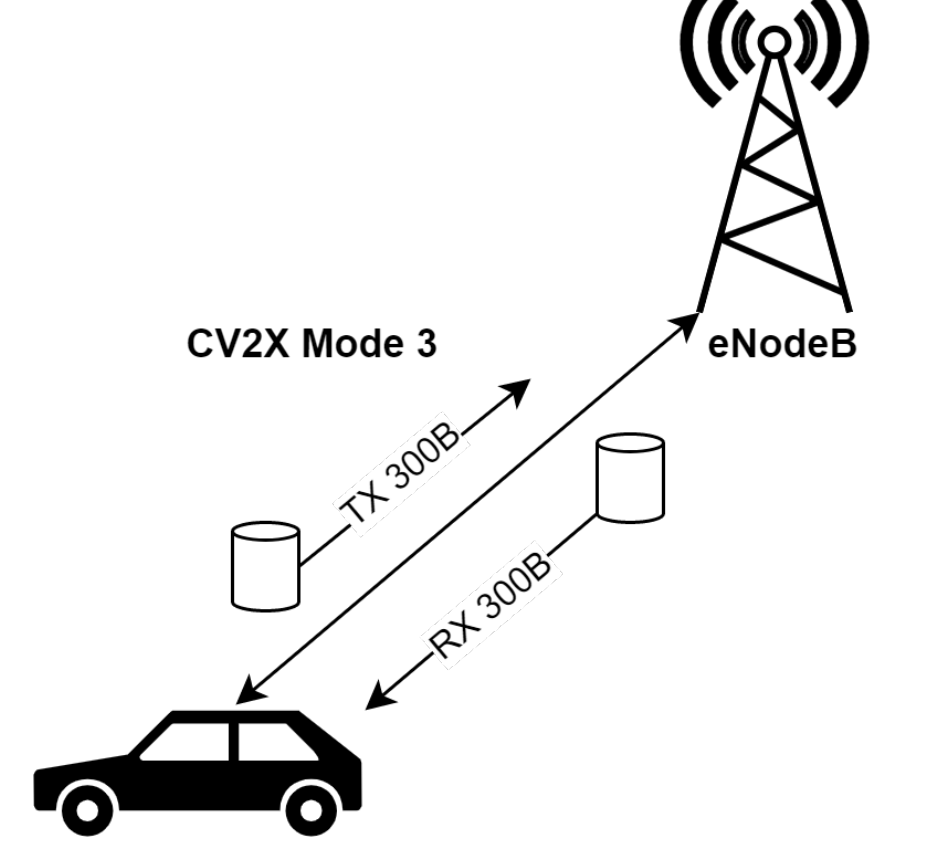
Figure 5. Emulated CV2X Mode 3 communication scheme. Table 8. Performance indicator standards for SINR